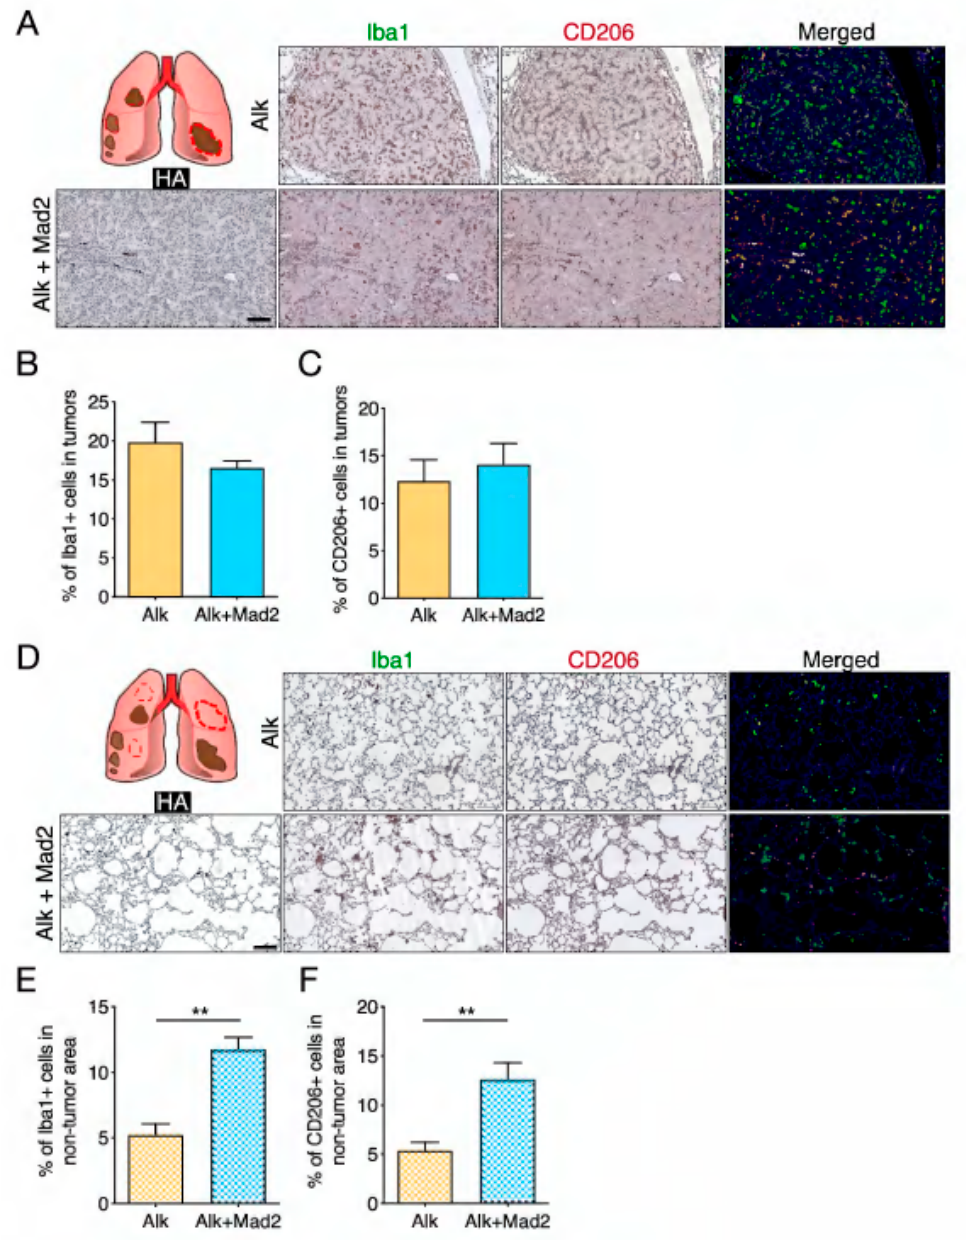
Figure 2. Macrophage content in lung tissues of Alk and Alk+Mad2 mice. ( A ) Representative images of multiplex immunohistochemical staining with antibodies for HA, Iba1, CD206, and their combinations (Hematoxylin-blue, HA-grey, Iba1-green, CD206-red) of tumors in Alk and Alk+Mad2 groups. Scale bar: 200 µ m ( B ) Percentage of Iba1 positive cells in tumors ( n = 4 mice). ( C ) Percentage of CD206 positive cells in tumors ( n = 8 mice). ( D ) Representative images of multiplex immunohistochemical staining with antibodies for HA, Iba1, CD206, and their combinations (Hematoxylin-blue, HA-grey, Iba1-green, CD206-red) of non-tumor areas in Alk and Alk+Mad2 groups. Scale bar: 200 µ m. ( E ) Percentage of Iba1 positive cells in non-tumor areas ( n = 4 mice). ( F ) Percentage of CD206 positive cells in non-tumor areas ( n = 8 mice) ** p < 0.05, Two-tailed t -test.